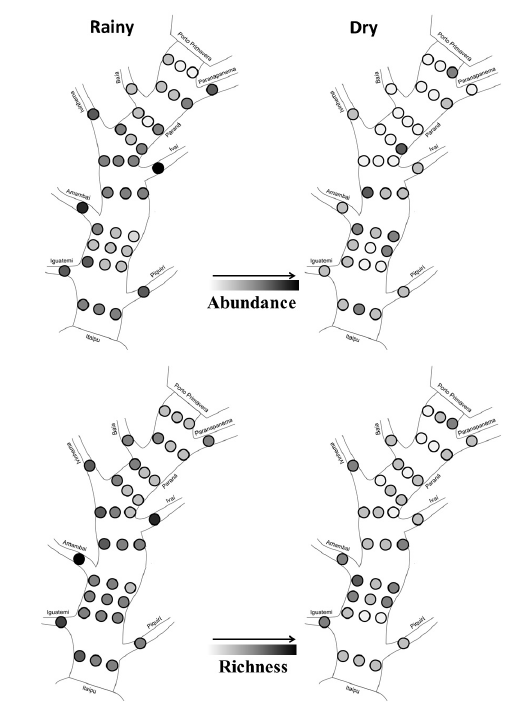
Figure 11. Schematic model showing the gradual change of the ciliate species abundance and richness as a resulting of the tributaries entrance along the main channel of the Paraná River on both